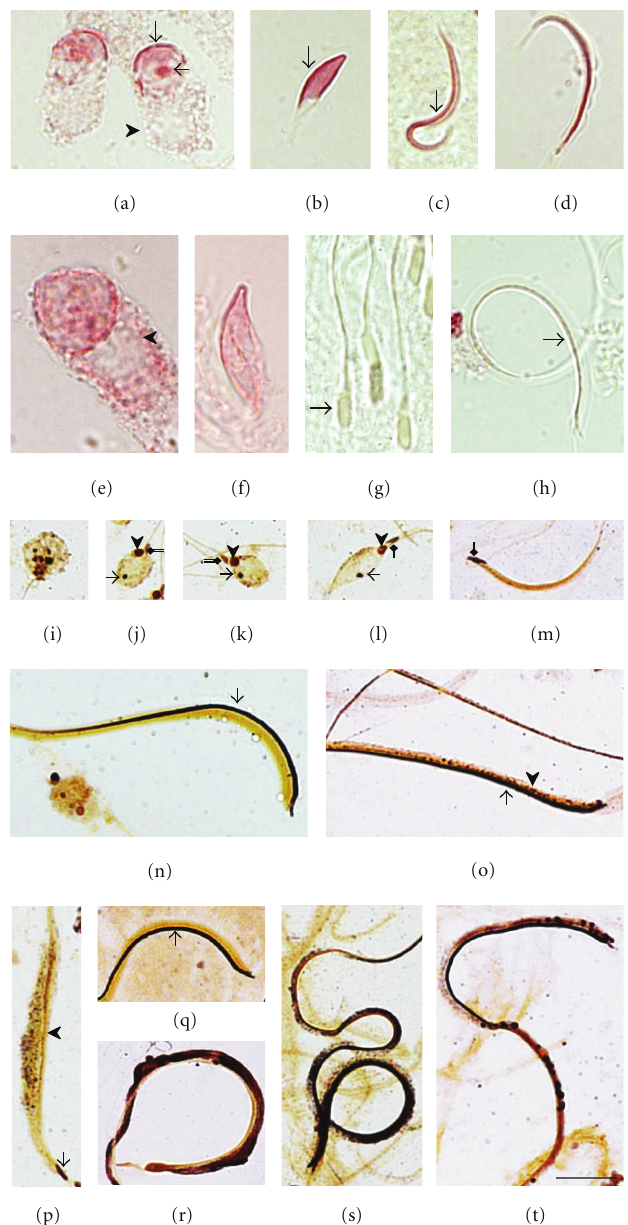
Figure 3: Spermiogenesis cells stained with lacto-acetic orcein ((a)–(h)) and silver impregnated ((i)–(t)). (a)–(d) Development of spermatids in lobes 1–3 and 5. (a) Round spermatids showing heteropyknotic material at the periphery and center of the nucleus (arrows) and a vesicle in the posterior region (arrowhead); (b) spermatid in elongation with heteropyknotic material at the periphery of the nucleus (arrow); (c) in a following stage, the heteropyknotic chromatin is visualized on only one side (arrow); (d) in a later stage, it becomes indistinguishable; (e)–(h) spermatids of lobes 4 and 6; (e) round spermatids showing a vesicle in the posterior region (arrowhead); (f) spermatid in elongation; (g) spermatid at the later stage of development with chromatin stained weakly and in the posterior region with a protuberance (arrow); (h) sperm showing a thin heteropyknotic chromatin on one side of the head (arrow); ((i)–(m)) round spermatid with several silver-positive bodies; ((j)–(l)) during the subsequent phases were observed three silver-positive bodies: one rod-shape and lighter close to region of tail formation ((j), smaller arrow), one round intensely stained (arrowhead), both in the posterior region of the spermatid and another smaller than others (bigger arrow) that was visualized in the middle region of the spermatid ((k), (l)); (m) spermatid in development with only one silver-positive body in the posterior region of the nucleus (arrow); (n) spermatozoon of lobes 1–3 with continuous silver-positive staining in the posterior region of the head (arrow) and in lobe 5 (o) a continuous positive silver impregnation (arrow) and several small bodies in all the nucleus (arrowhead). ((p)–(t)) Spermiogenesis of lobes 4 and 6; (p) spermatid in development showing strong silver-positive body in the posterior region of the head (arrow), several small silver-positive bodies in the middle region and a line-shaped silver staining from middle to anterior region (arrowhead); ((q)–(t)) developed spermatids showing four silver-positive behaviors: (q) continuous and linear (arrow); (r) large and amorphous; (s) linear and throughout the extent of the head and several round and small silver-positive bodies and (t) with the same previous characteristics, but the silver-positive bodies are larger and smaller in number. Bar = 10 µ